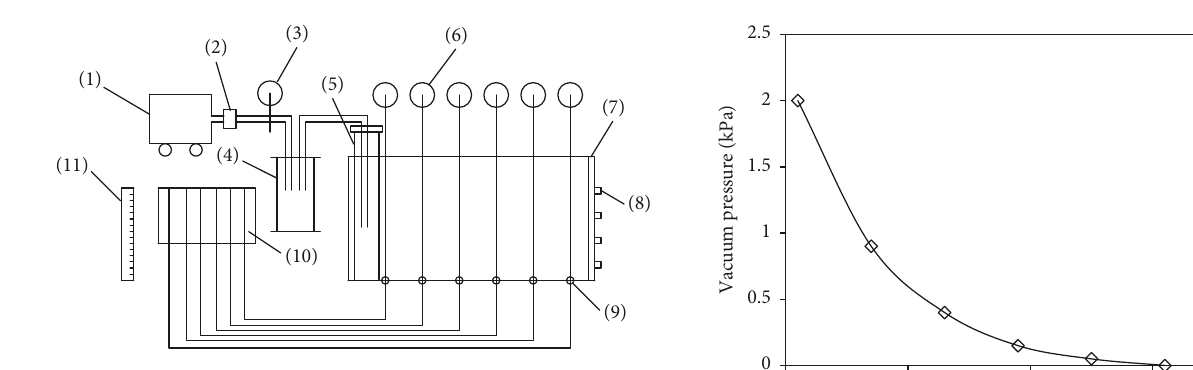
Figure 4: Schematic diagram of the experimental device. (1) Air compressor, (2) vacuum generator, (3) vacuum pressure gauge, (4) water separator, (5) dewatering well, (6) gauge, (7) water sink, (8) waterhead control, (9) pipes, (10) water level monitoring device, and (11) ruler.